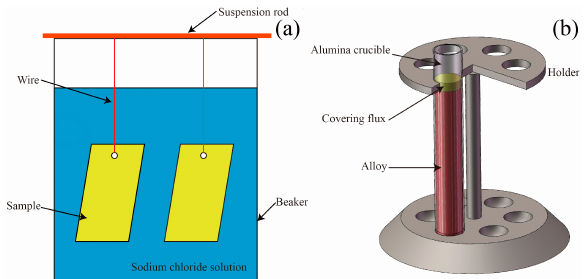
Figure 1. Schematic diagram of the experiment: ( a ) Immersion corrosion test [25], and ( b ) dross formation.